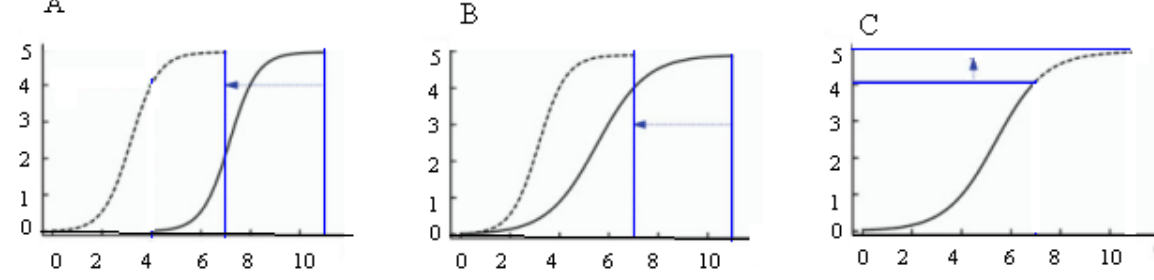
Figure 3. Sketch map of the parameters related to the change in the growth curve. ( A – C ) show the inflection point moving forward, acceleration of the growth, and increase in the potential, respectively. The arrows between two lines indicated the moving direction of the curves. The solid and dotted lines represented the original and new curves, respectively